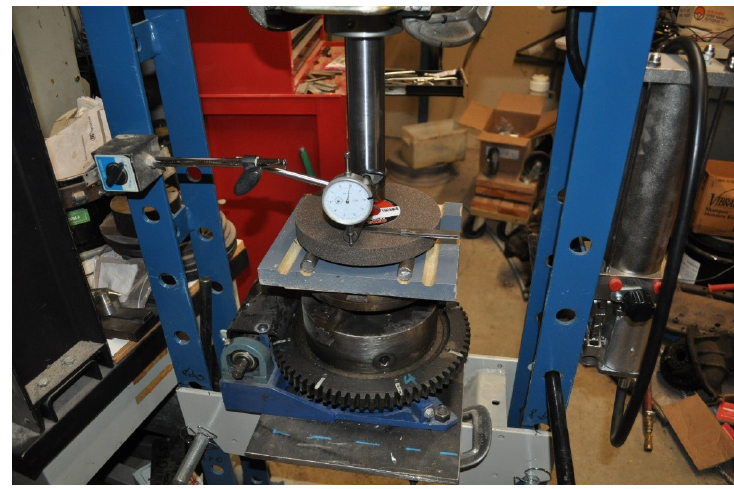
Figure 2. Three-point bending fixture to crack the grinding wheels.